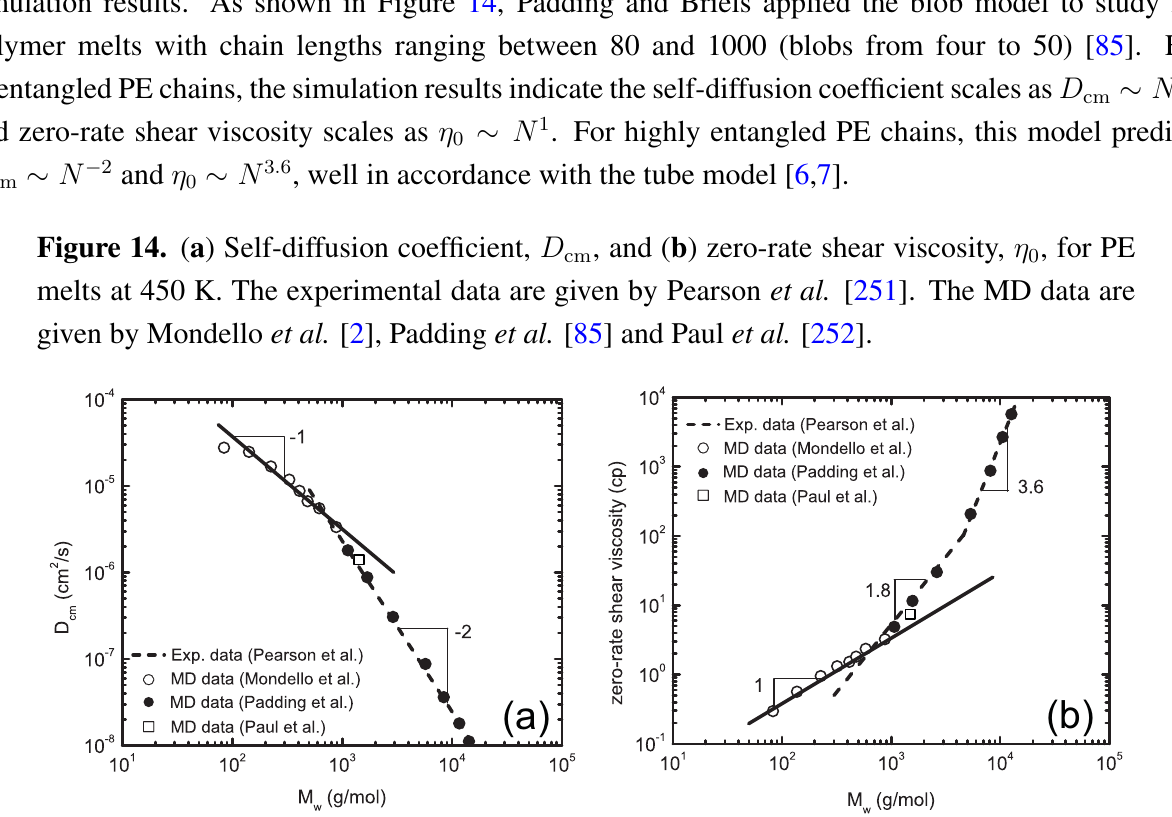
Figure 14. ( a ) Self-diffusion coefficient, D